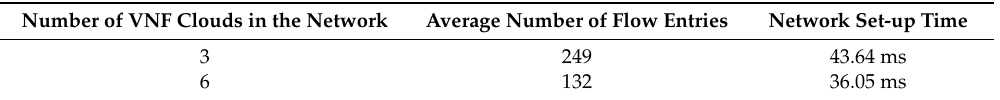
Table 3. Orchestrator performance with different number of VNF clouds and with three VNFs in the chain.